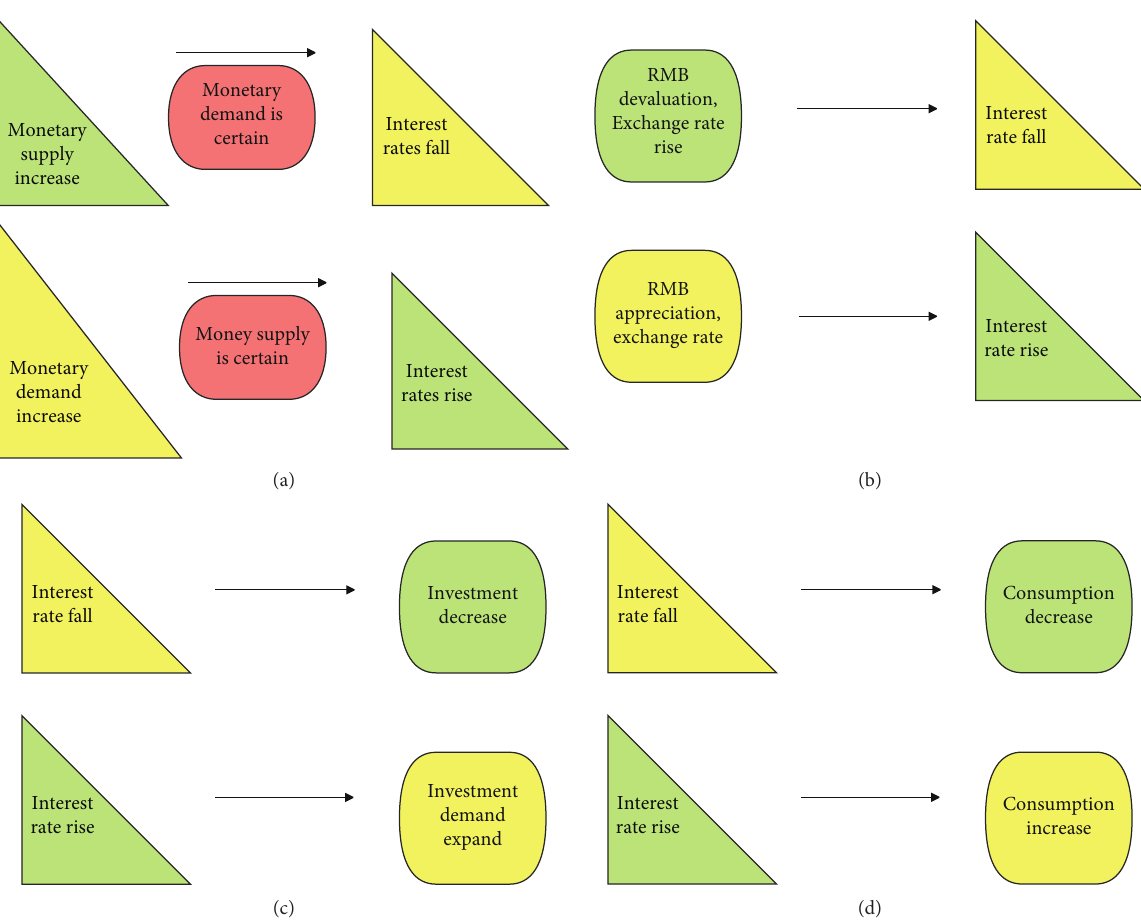
Figure 4: Analysis of the relevance between interest rates and the economy. (a) Interest rate fluctuation mechanism based on changes in money supply. (b) Interest rate fluctuation mechanism based on exchange rate fluctuations. (c) The formation mechanism of the investment effect of interest rate fluctuations. (d) The formation mechanism of the consumption effect of interest rate